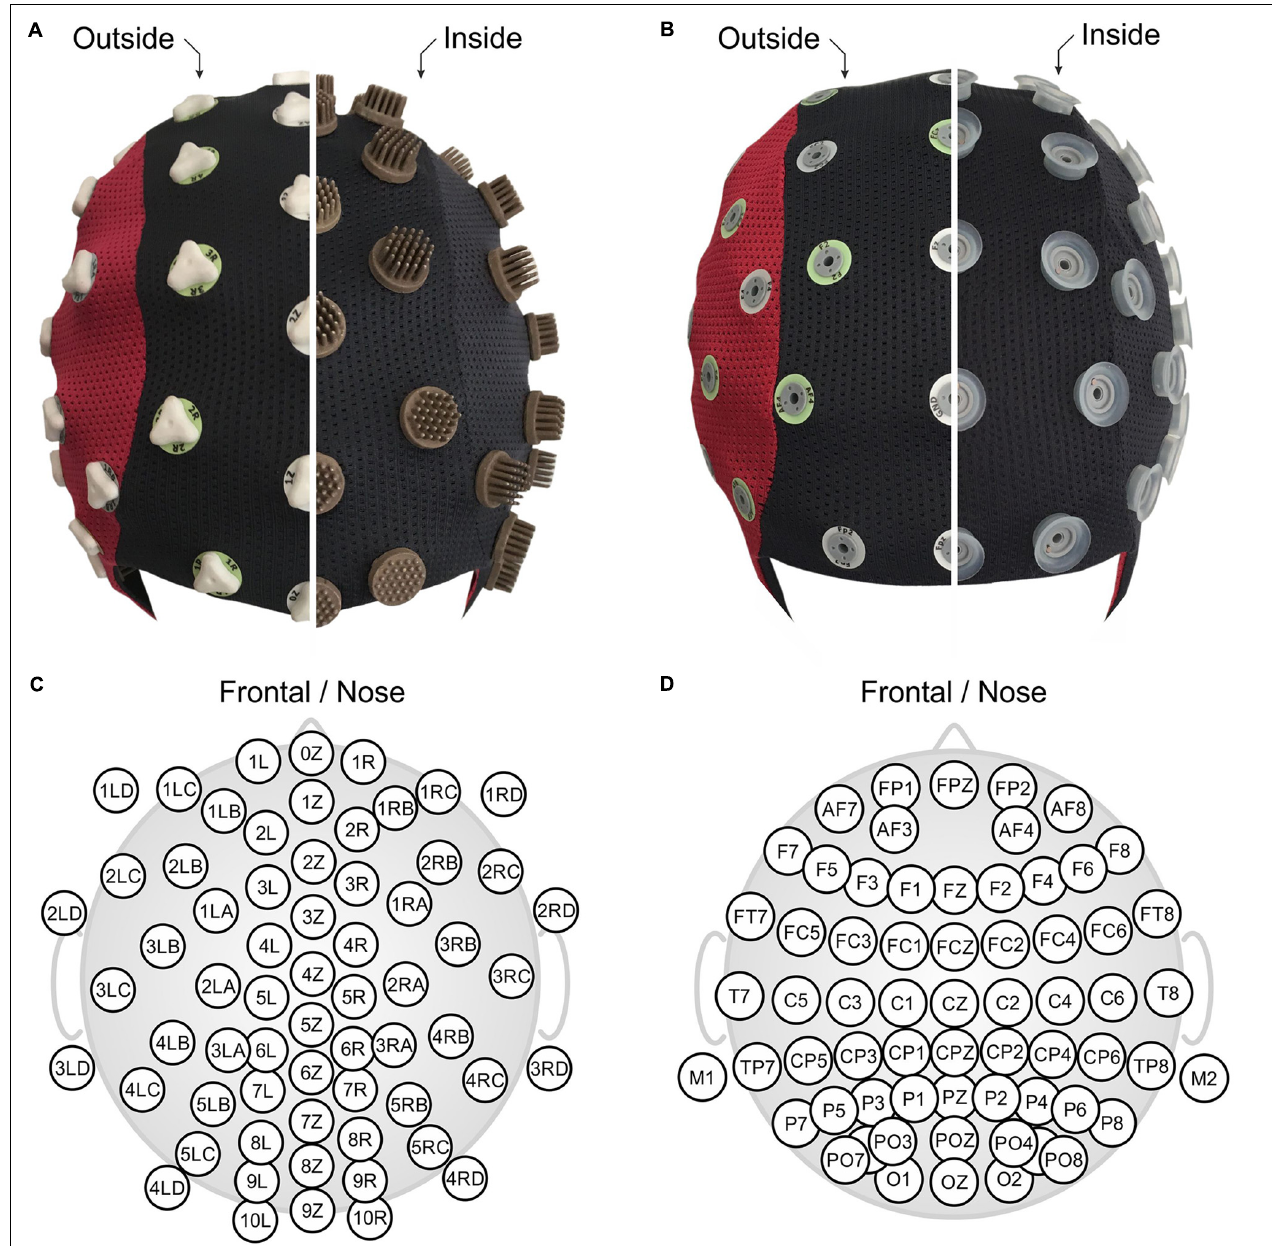
FIGURE 1 | The two compared EEG caps shown turned inside out: (A) 64-channel dry PU-AgCl multipin electrode cap with equidistant layout, and (B) 64-channel gel-based sintered AgCl electrode cap with extended 10–20 layout. Corresponding detailed 2D electrode topographic layouts are shown in panels (C,D) for the dry- and the gel-based caps. Panels (A,B) are in front view (nose on bottom), and panels (C,D) show nose on